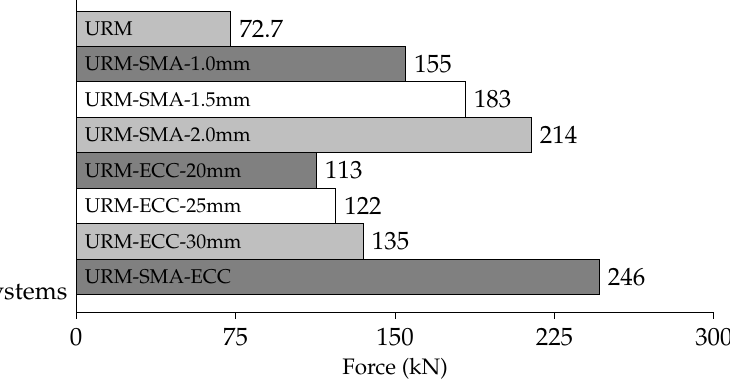
Figure 25. Maximum force at a reference point in each